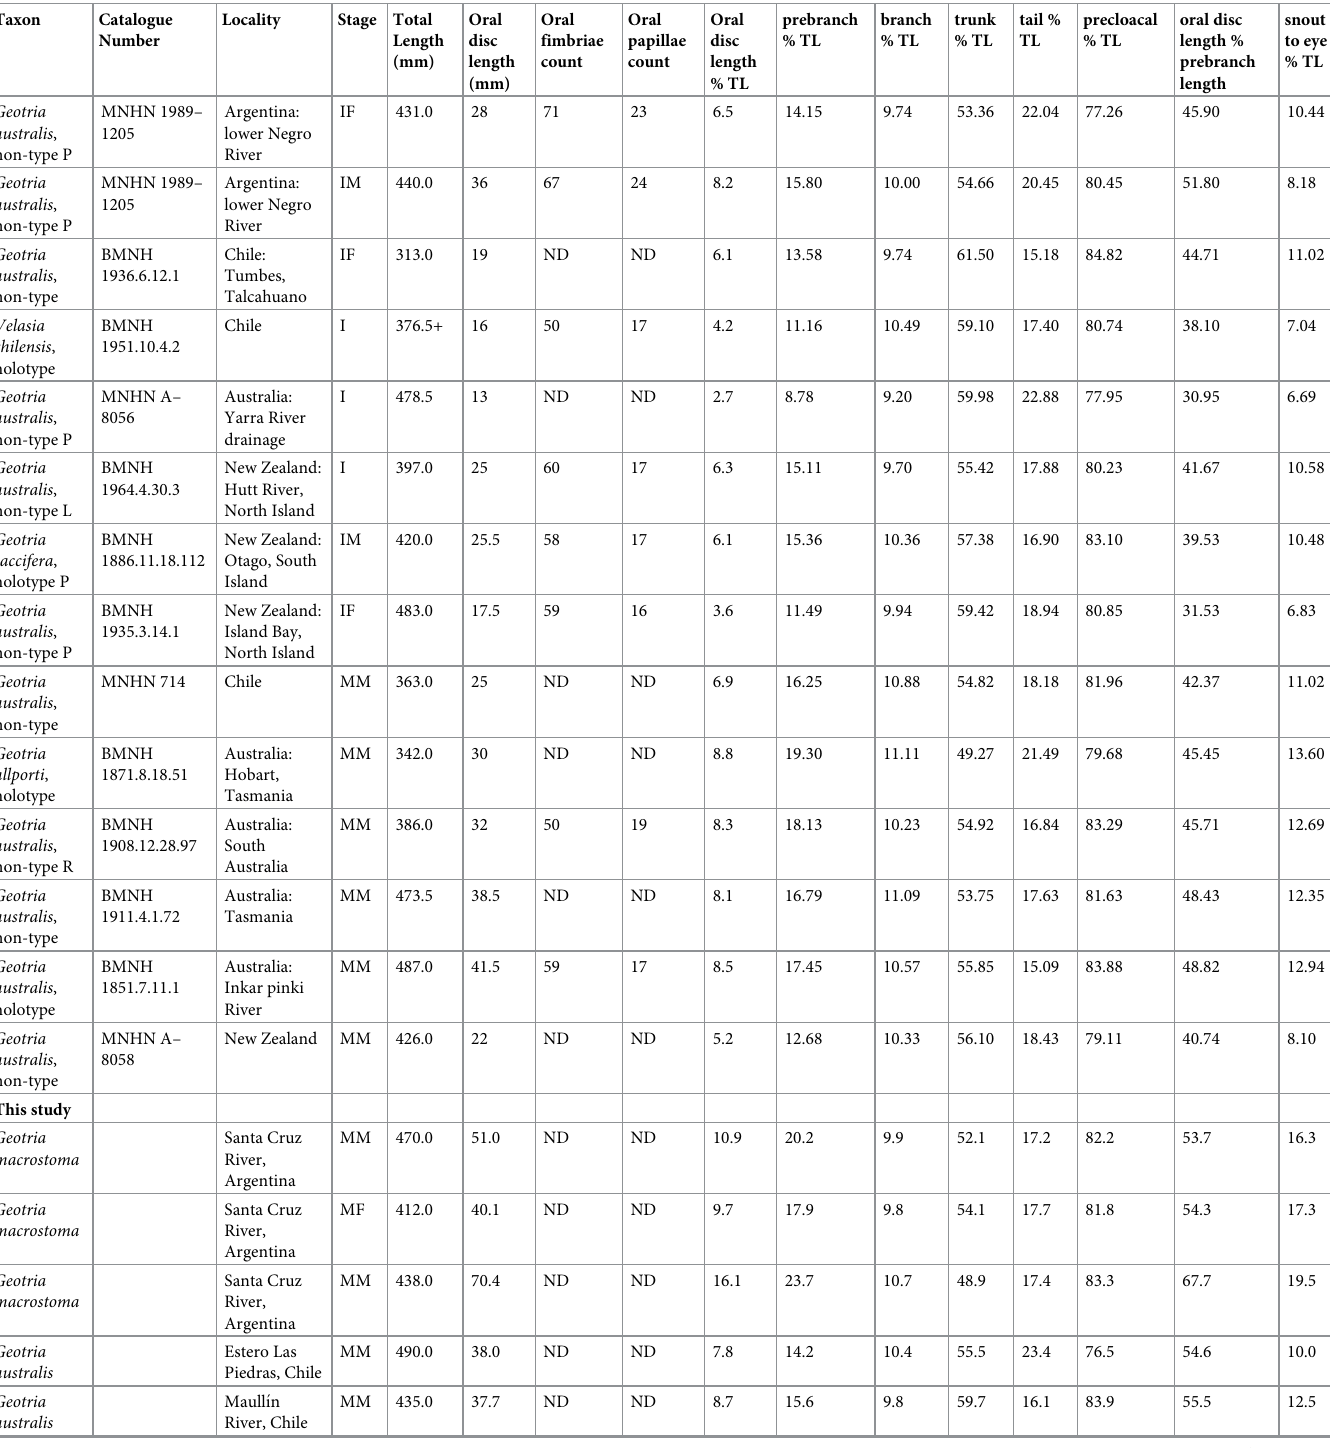
Table 1. Comparisons of morphological characters of immature and mature adults of Geotria australis and its synonyms with those recorded in the present study of six lamprey populations (Chubut and Santa Cruz rivers, Argentina; Temuco, Chile; Waikawa and Mokau rivers, New Zealand; Murray River, Australia),